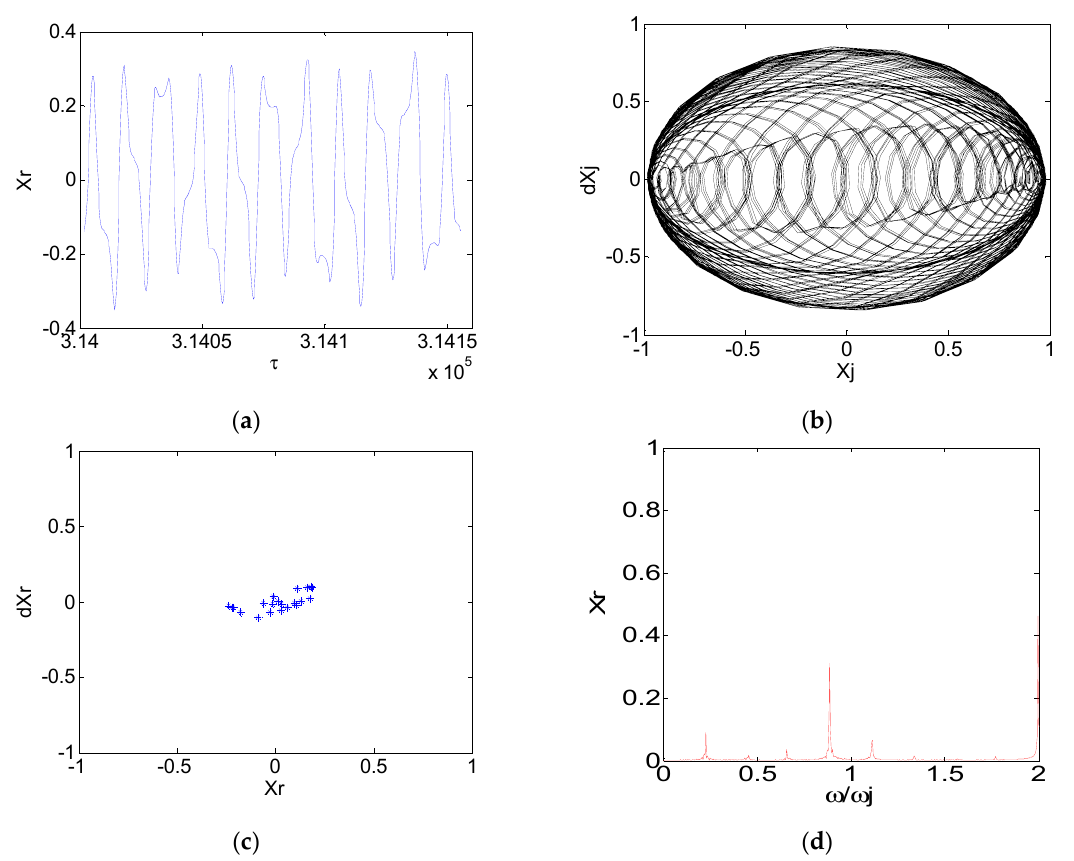
Figure 9. Dynamic response of the floating ring system λ = 0.01 and speed ratio is S = 2.47: ( a ) time-domain waveform; ( b ) orbit; ( c ) Poincare section; ( d ) the FFT spectrum of the disk .